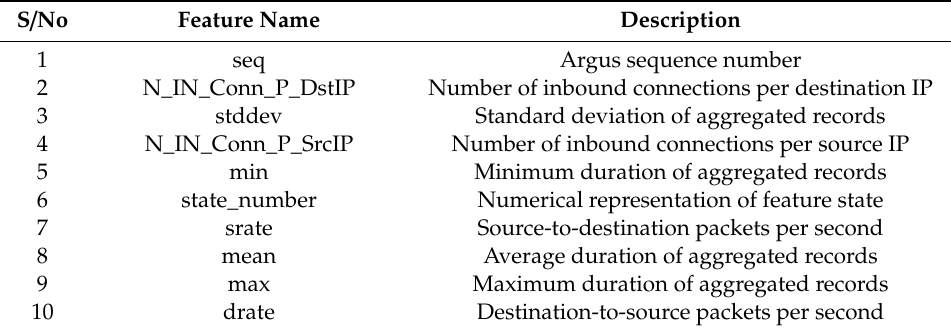
Table 5. Features Selected for Experiments.